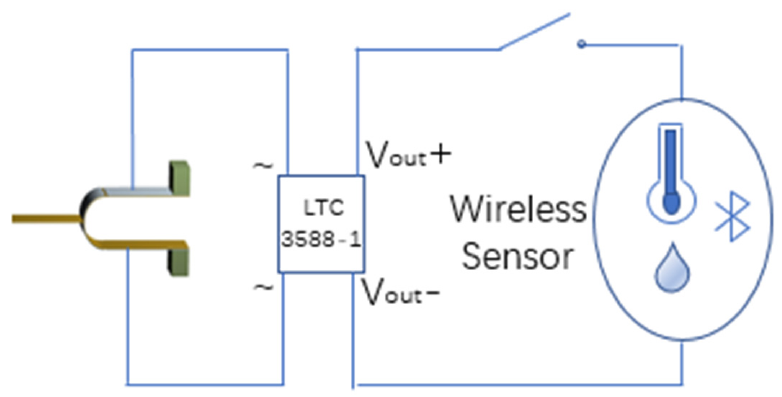
Figure 12. Circuit diagram used to power humidity sensors. The excitation acceleration is 0.7 g, the impact spacing is 1.5 cm, and the excitation frequency is 7.7 Hz. The experimental results show that the voltage starts to rise gradually because the capacitor in LTC3588 needs to be charged for a short time after the excitation is applied and then becomes stable after about 8 s, as shown in Figure 13.